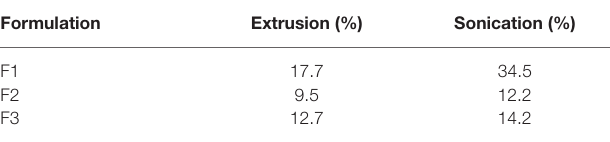
TABLE 5 | Efficiency of encapsulation for the formulations F1, F2, and F3.